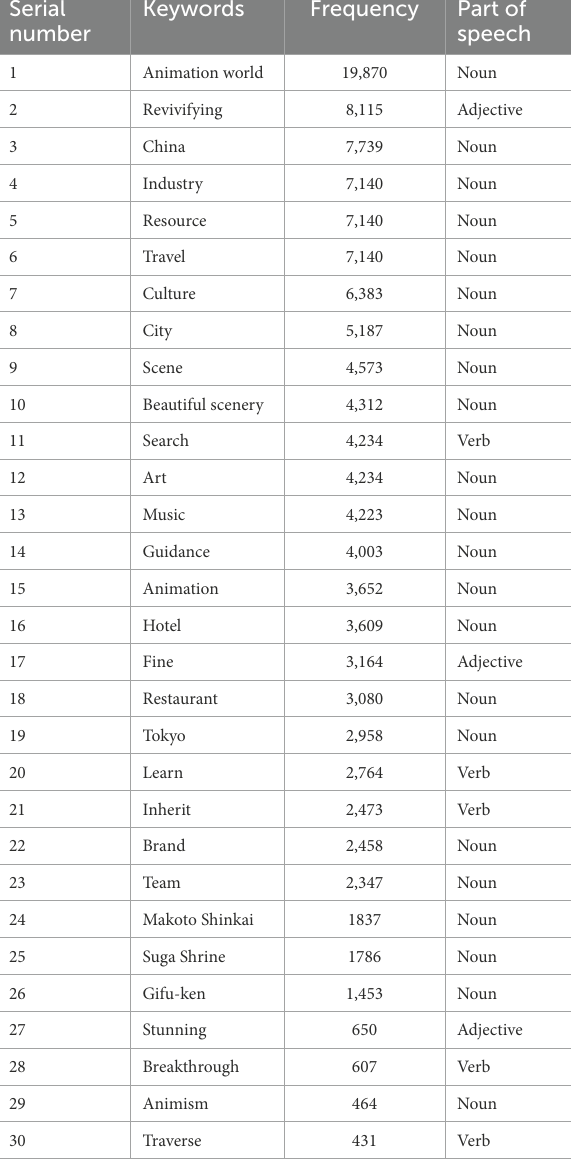
TABLE 2 Interest-related community interaction based on tourists (top